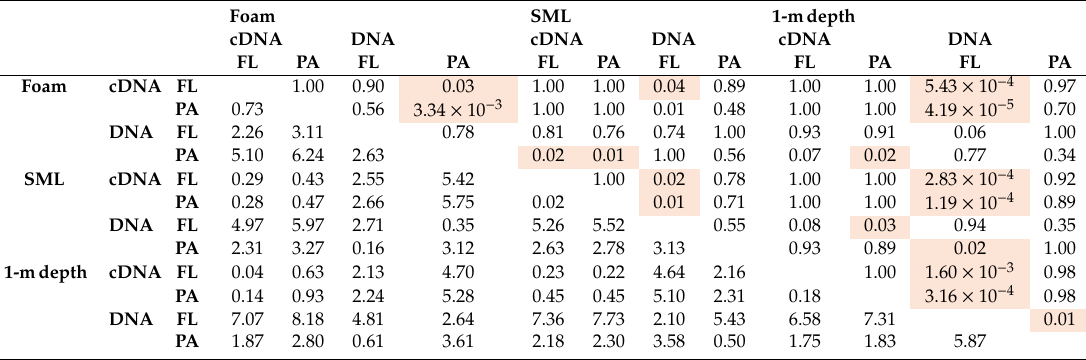
Table A2. Results of statistical analysis for Figure 2. There was a significant di ff erence between sample medians (Kruskal–Wallis Test, chi-squared: 36.14, p -value = 1.6 × 10 − 4 ). In this table, the upper diagonal reflects p -values after Tukey HSD test with significant results ( p ≤ 0.05 indicated in orange) and Tukey’s Q value in the lower diagonal. FL = free-living, PA = particle-associated, SML = sea-surface